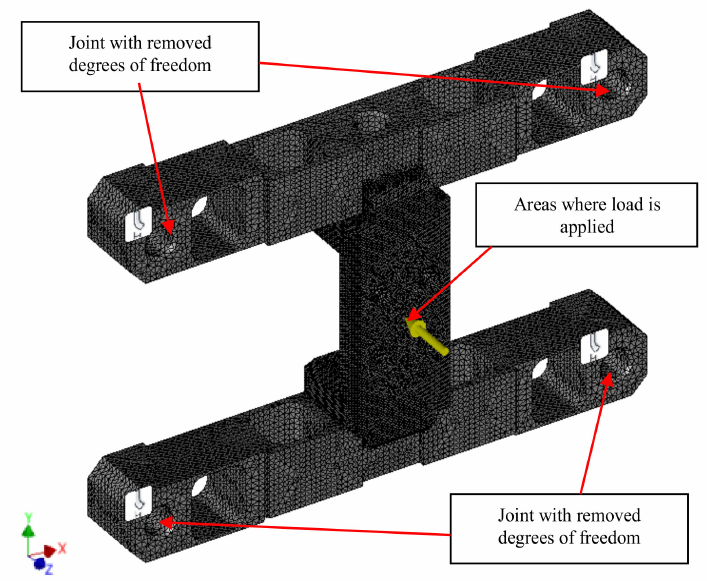
Figure 6. Transducer calculation